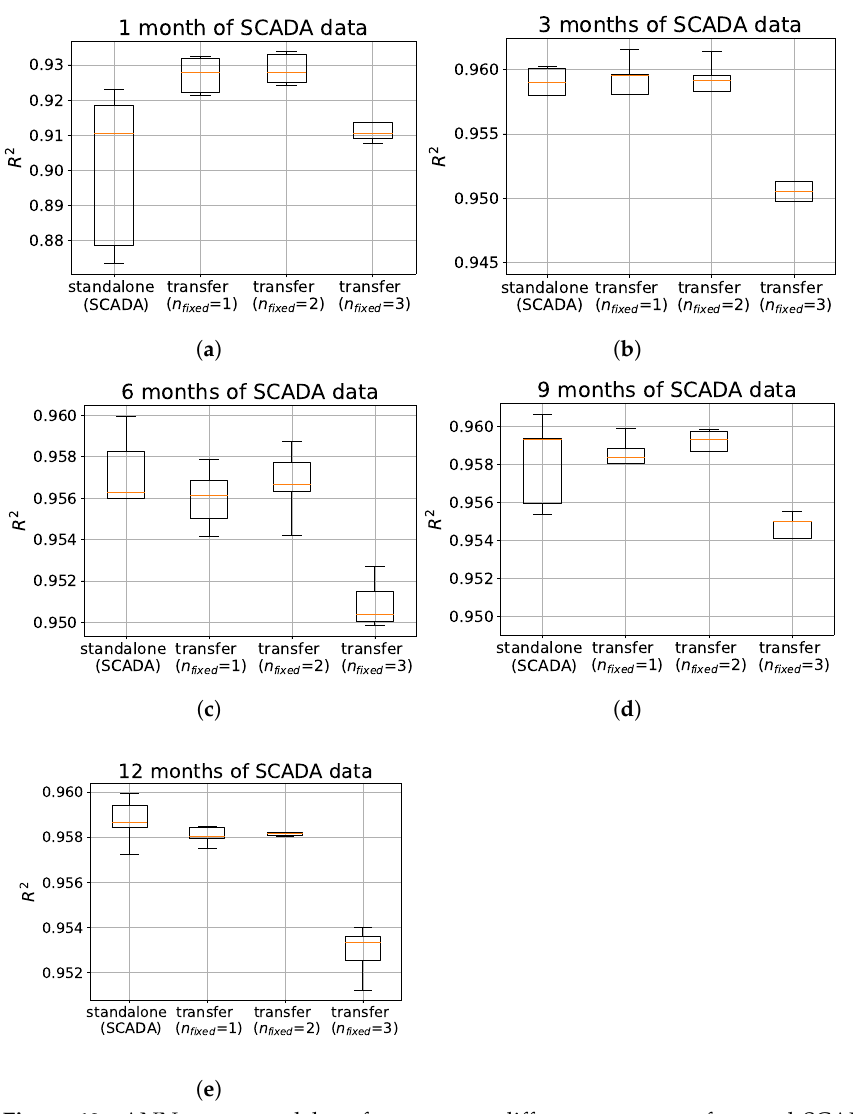
Figure 10. ANN target model performance on different amounts of normal SCADA data and knowledge transfers. Each boxplot represents the R 2 distribution of the models trained within the five-fold crossvalidation. The target models are trained using 1 month ( a ), 3 months ( b ), 6 months ( c ), 9 months ( d ), and 12 months ( e ) of normal SCADA